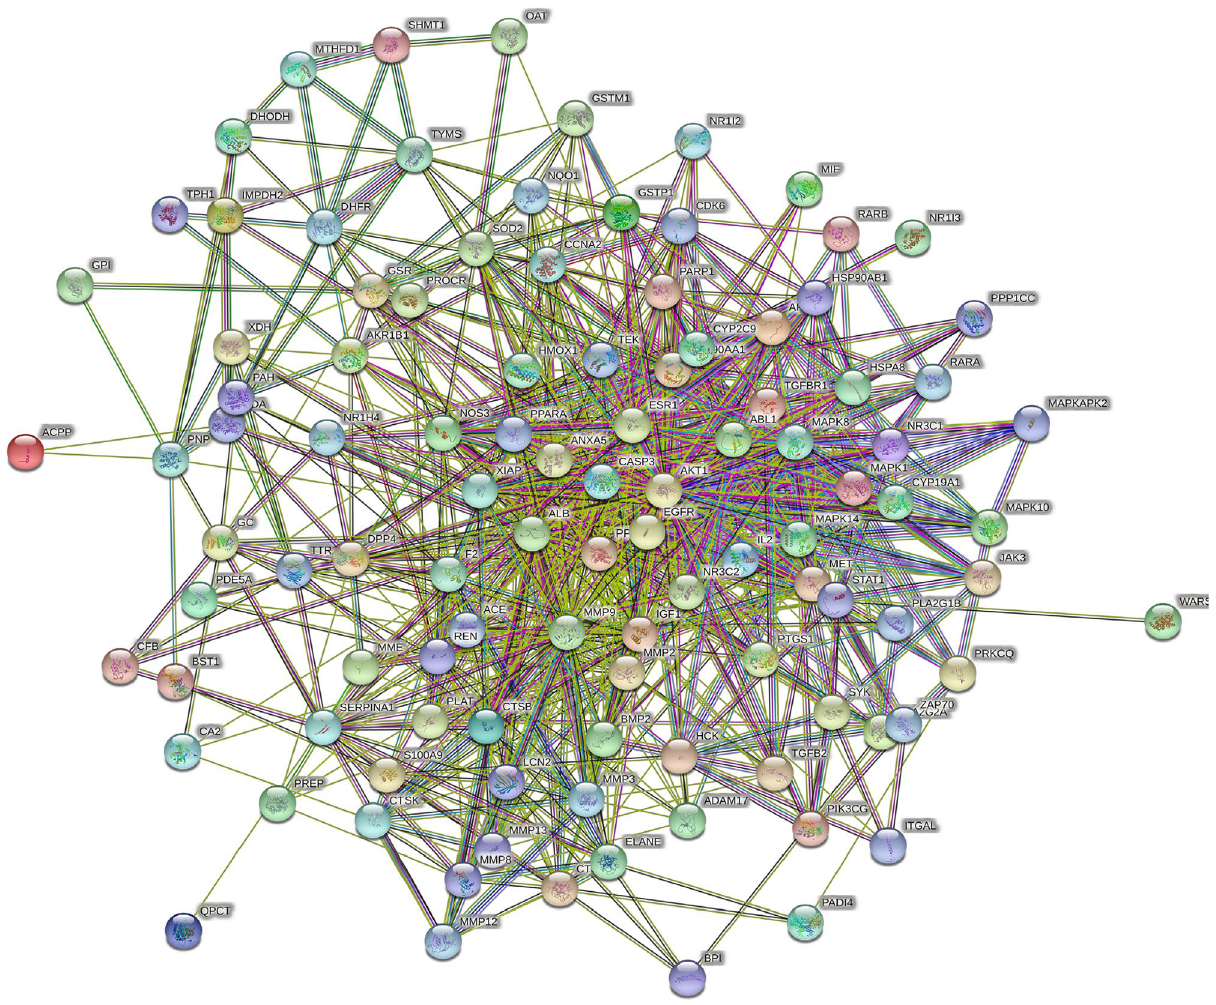
Figure 2. Protein–protein interaction (PPI) network analysis of 105 potential targets was generated by String (Version, 11.5) (https:// cn. string- db.